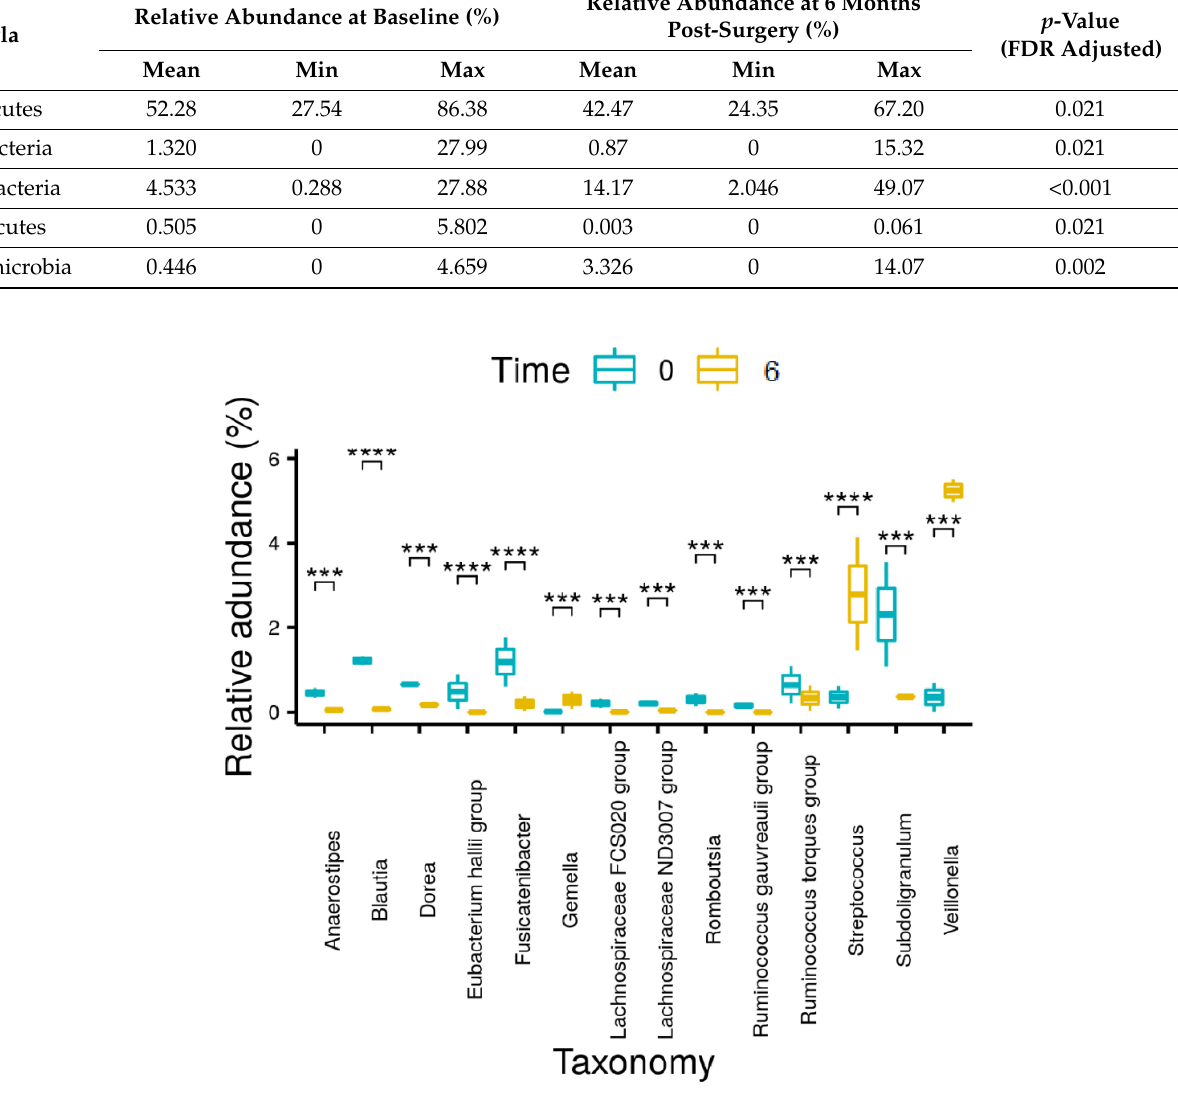
Figure 3. Changes in relative abundances of genera for all patients ( n = 28) from baseline (Time 0) to 6 months post-surgery (Time 6). Significant differences in abundance are marked with an asterisk (*** indicates p < 0.0005; **** indicates p < 0.00005). Note that only significant differences in abundance with p < 0.0005 are presented